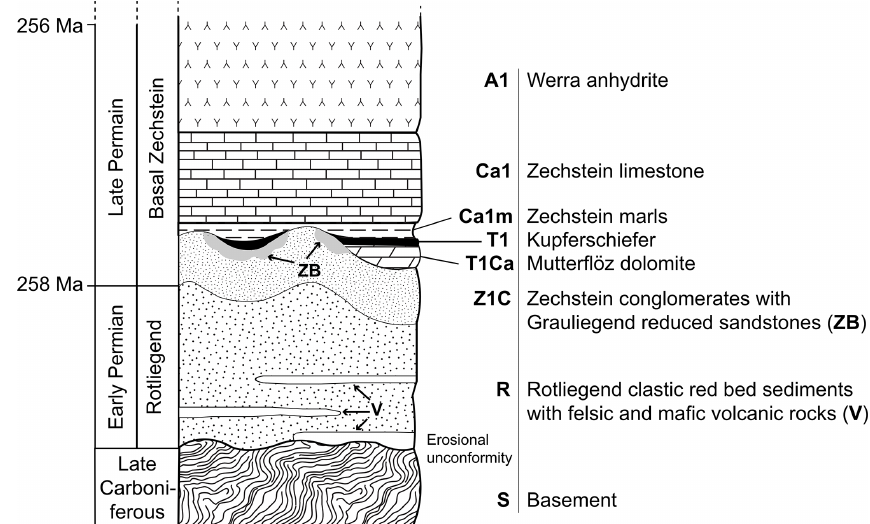
Figure 1. Stratigraphic units in the southern part of the CESB – modified after Kopp et al.